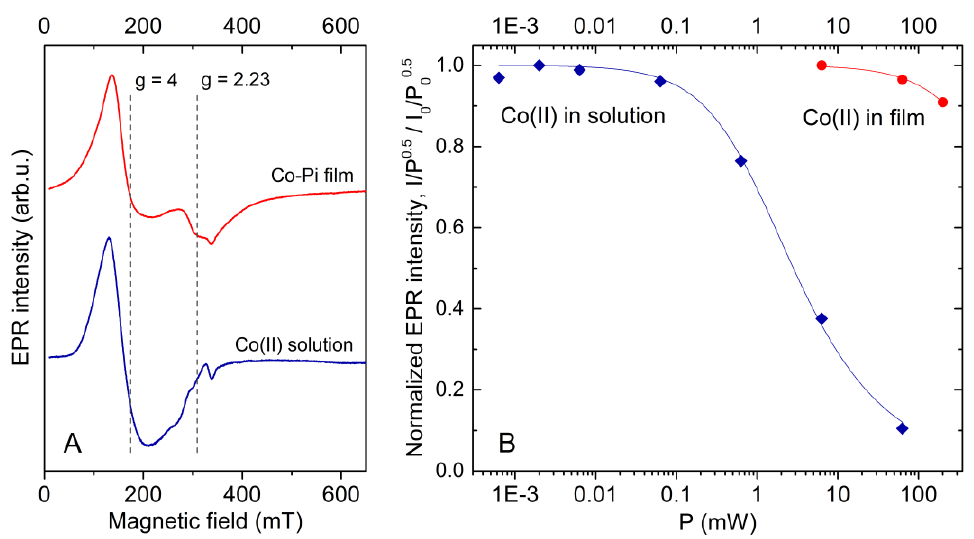
Figure 1. ( A ) X-band CW electron paramagnetic resonance (EPR) spectra of a cobalt oxide (Co-Pi) catalyst film electrodeposited at 0.9 V from an aqueous 1 mM Co(NO 3 ) 2 solution in 0.1 M Pi electrolyte (red) and Co(II) in the starting solution (blue) measured at T = 5 K and P MW = 6.3 mW. ( B ) Normalized EPR intensity of Co(II) in the Co-Pi film (red circles) and electrolyte solution (blue diamonds) as a function of P MW with T = 5 K. Simulations obtained using (1 + P / P 1/2 ) − 0.5 are shown with solid lines, with best fit P 1/2 values of 1 ± 0.2 mW for the solution and 945 ± 35 mW for the film species.